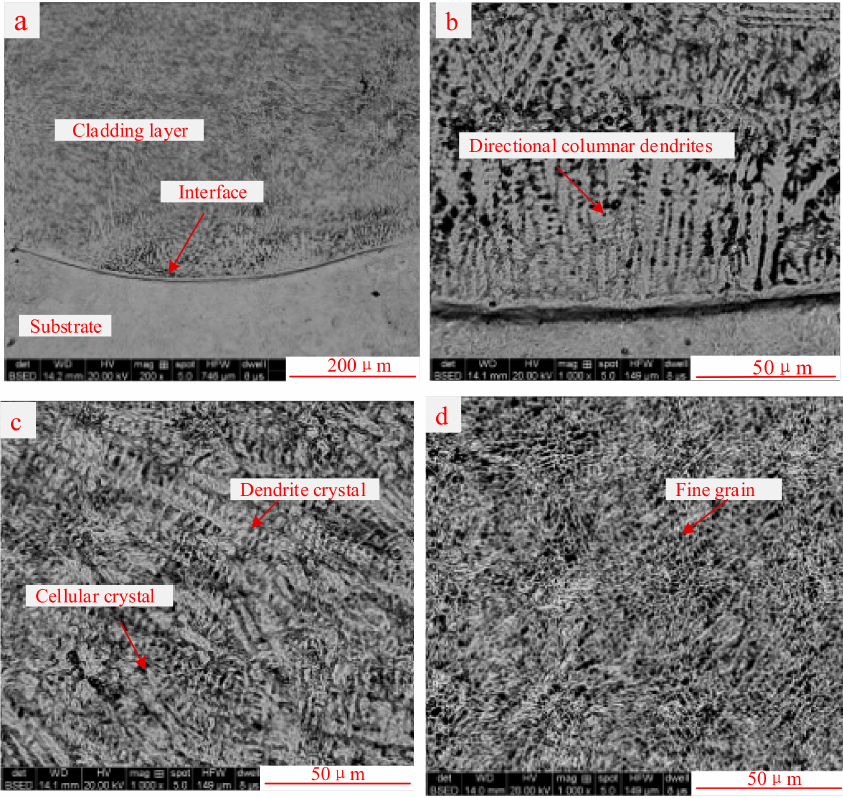
Figure 10. SEM micrograph of the coating: ( a ) The overview of the cladding layer, ( b ) the bottom zone, ( c ) the middle zone and ( d ) the top